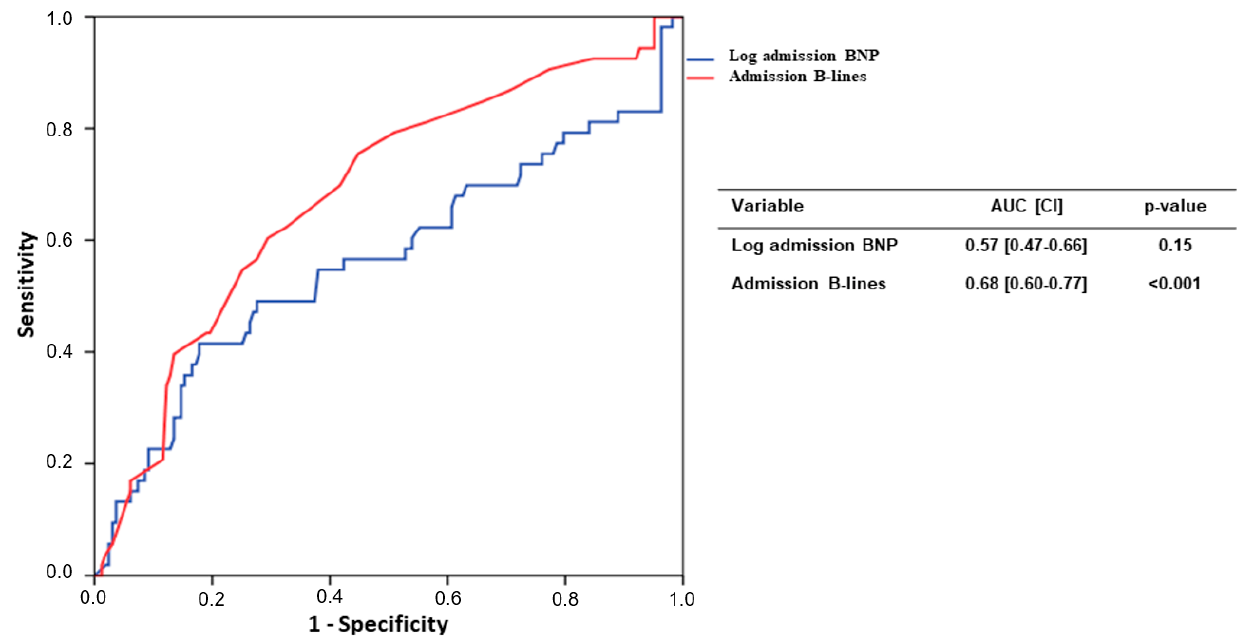
Figure 2. ROC curve analysis of admission BNP values and B-lines number.